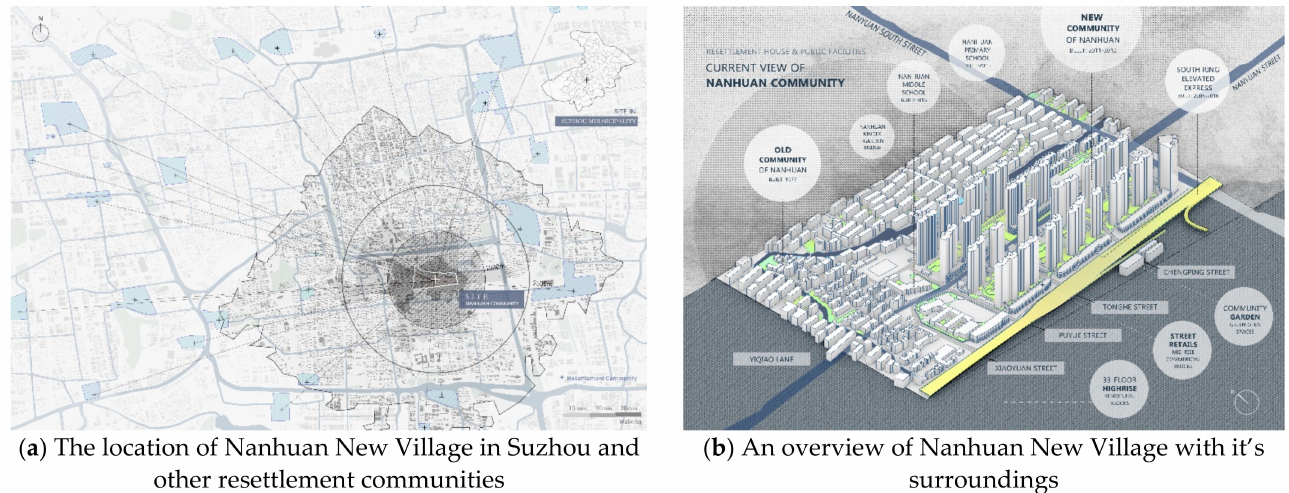
Figure 3. The geographic location of the study area, area boundaries, and contextual